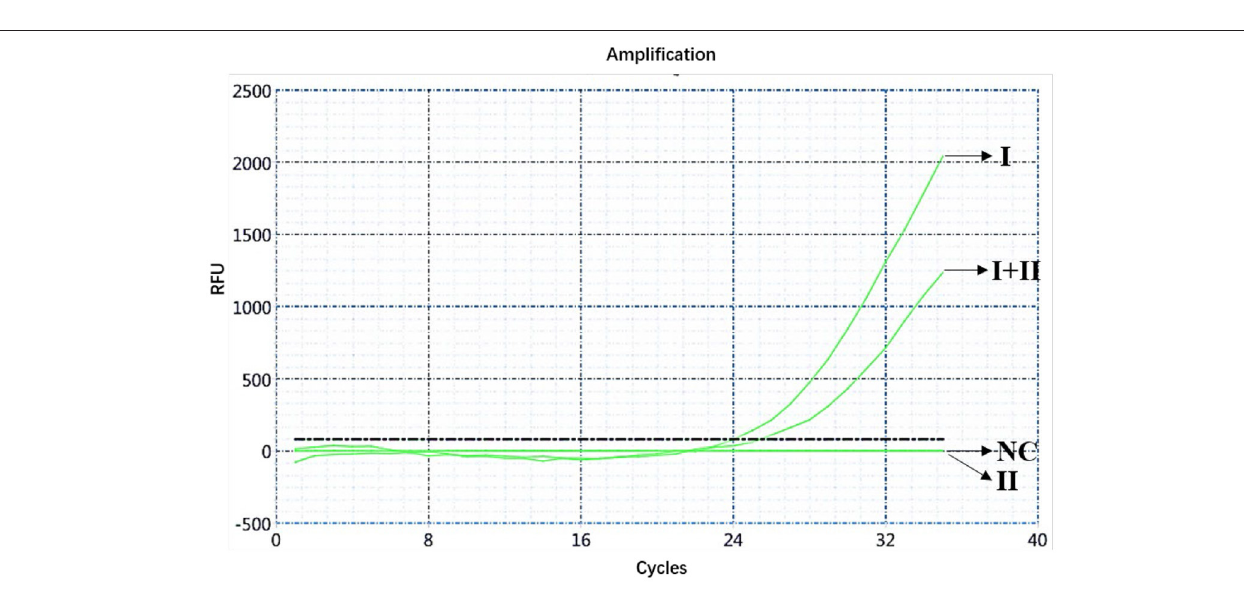
FIGURE 2 | Amplification curve for the HEX channel determined through nucleic acid double fluorescence quantitative PCR of ASFV genotypes I and II, ASFV genotypes I and II mixed samples, and negative pig